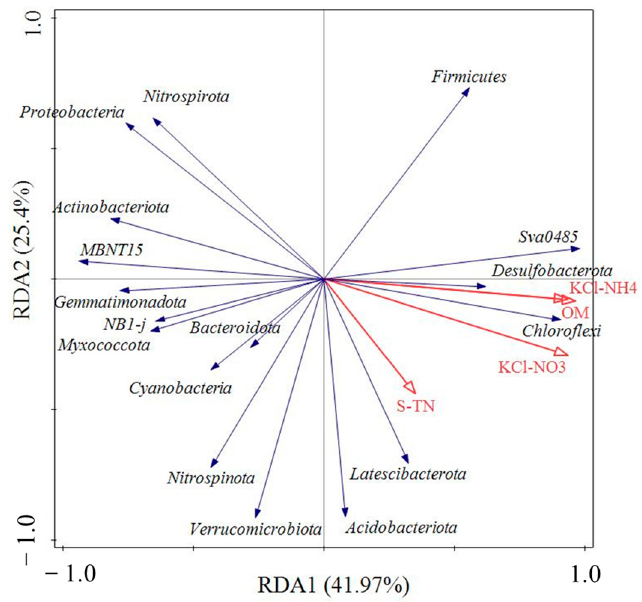
Figure 8. RDA analysis of bacterial community at the phylum level and environmental factors.